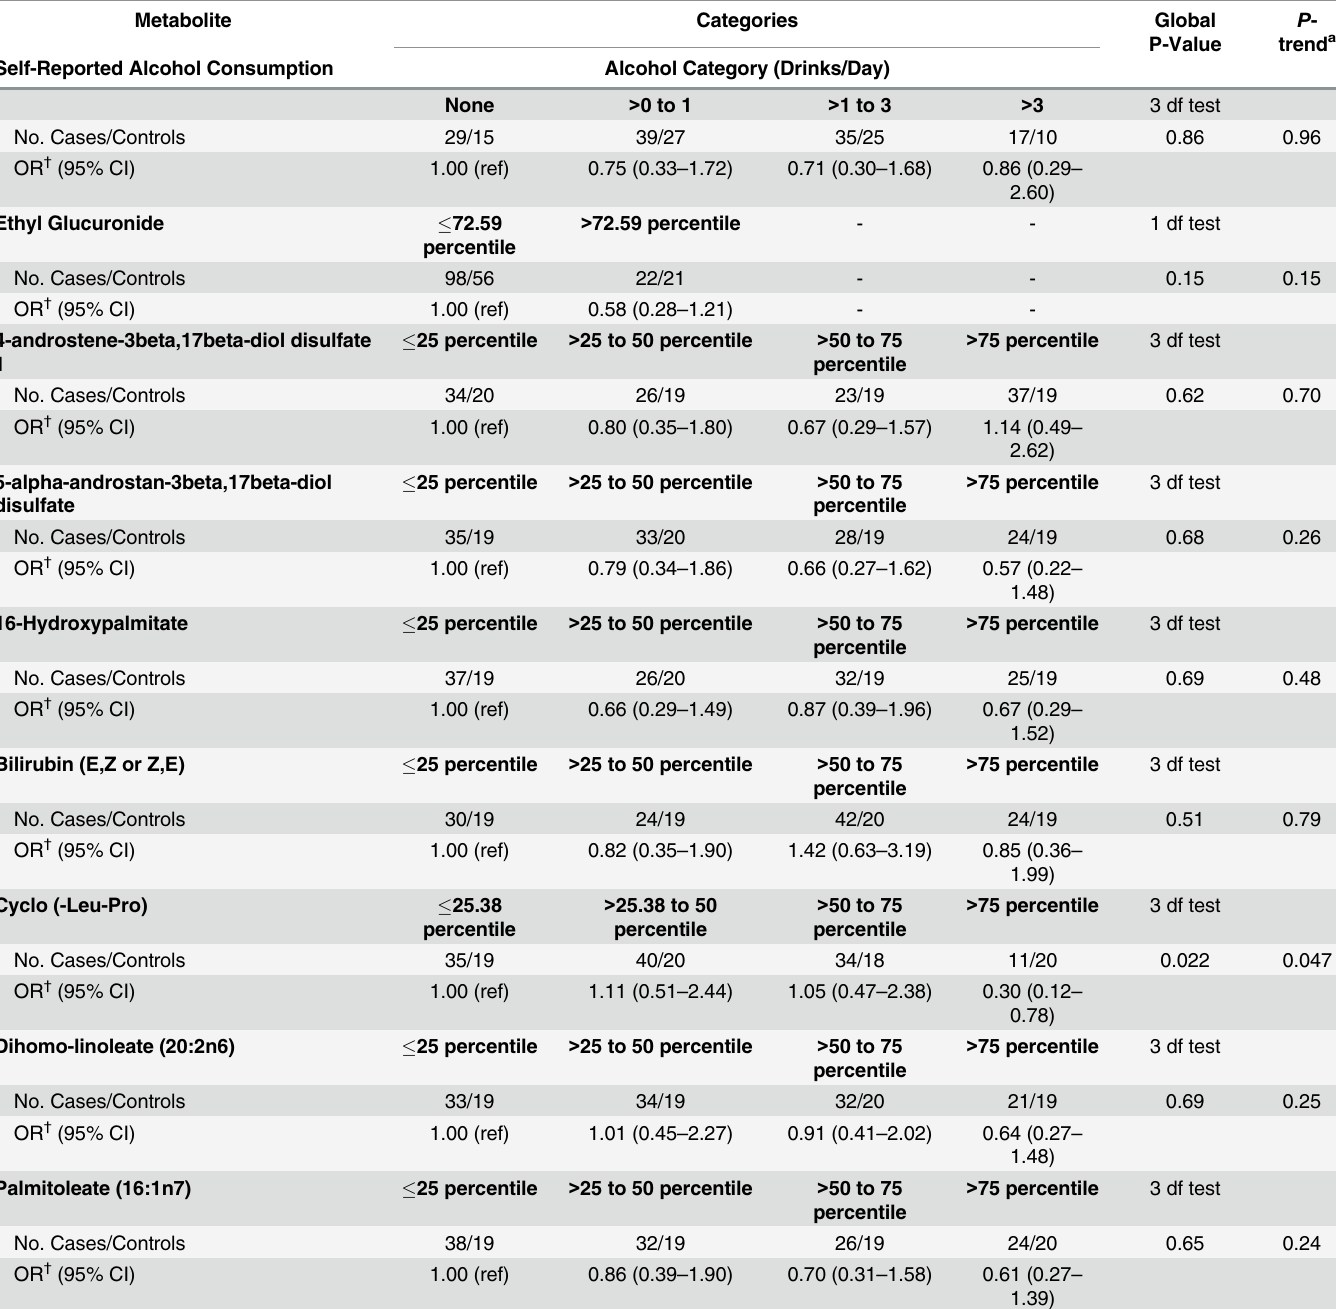
Table 4. Adjusted Odds Ratios and 95% Confidence Intervals for the Association Between Self-Reported Alcohol Consumption/Alcohol Consump- tion-Related Metabolites and Colorectal Adenoma in 197 US Adults (Navy Colon Adenoma Study). Metabolite